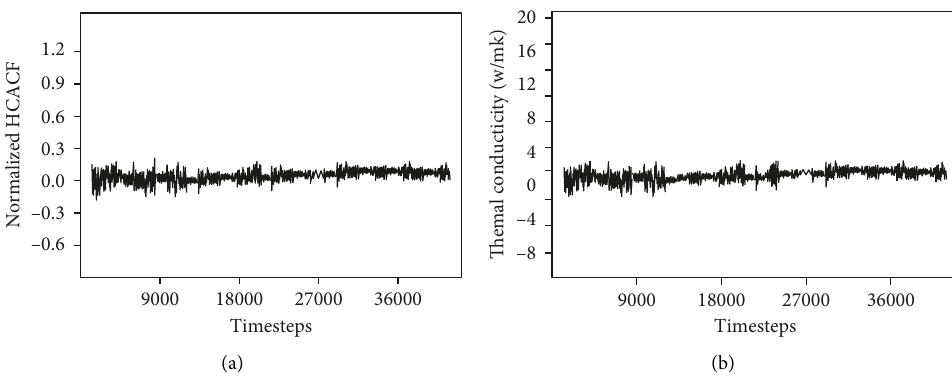
Figure 5: Heat flow correlation function (a) and thermal conductivity (b) of composites at 280K.